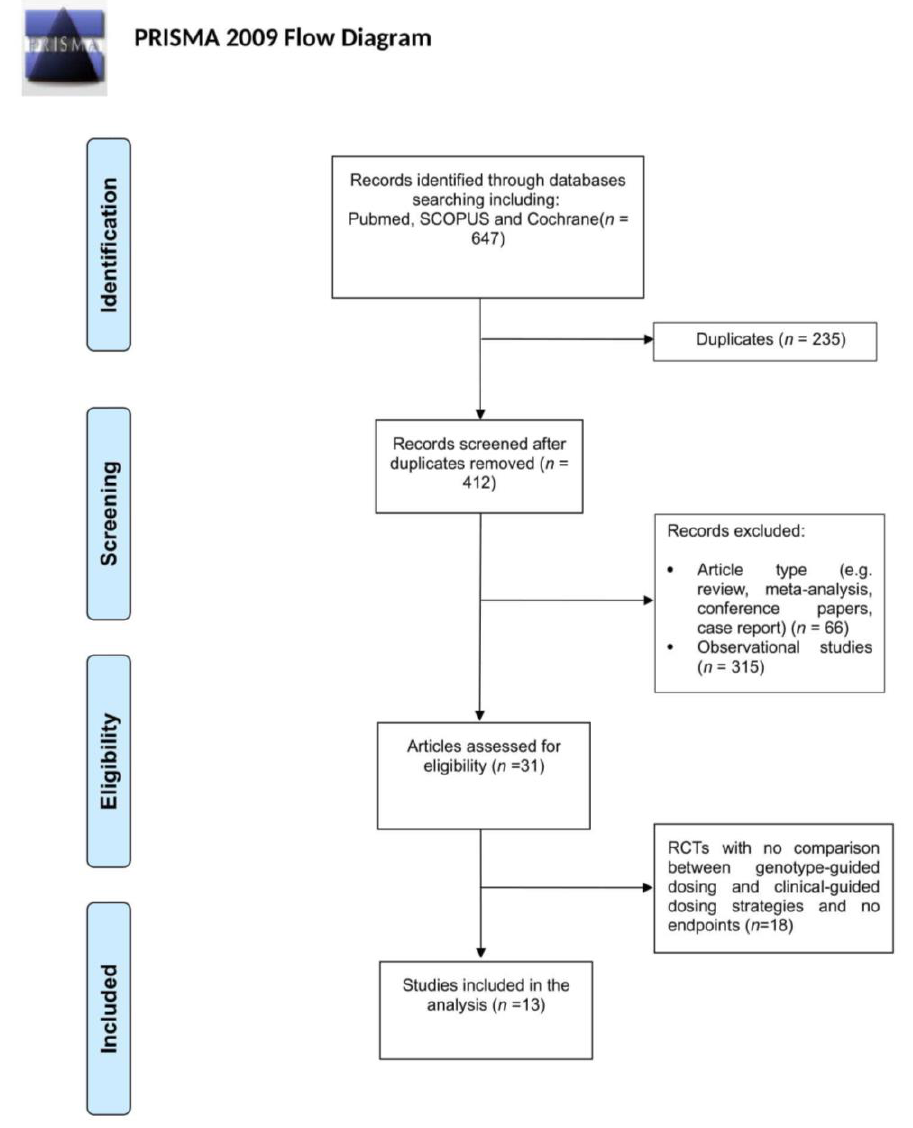
Figure 1. Flowchart of the systematic review.